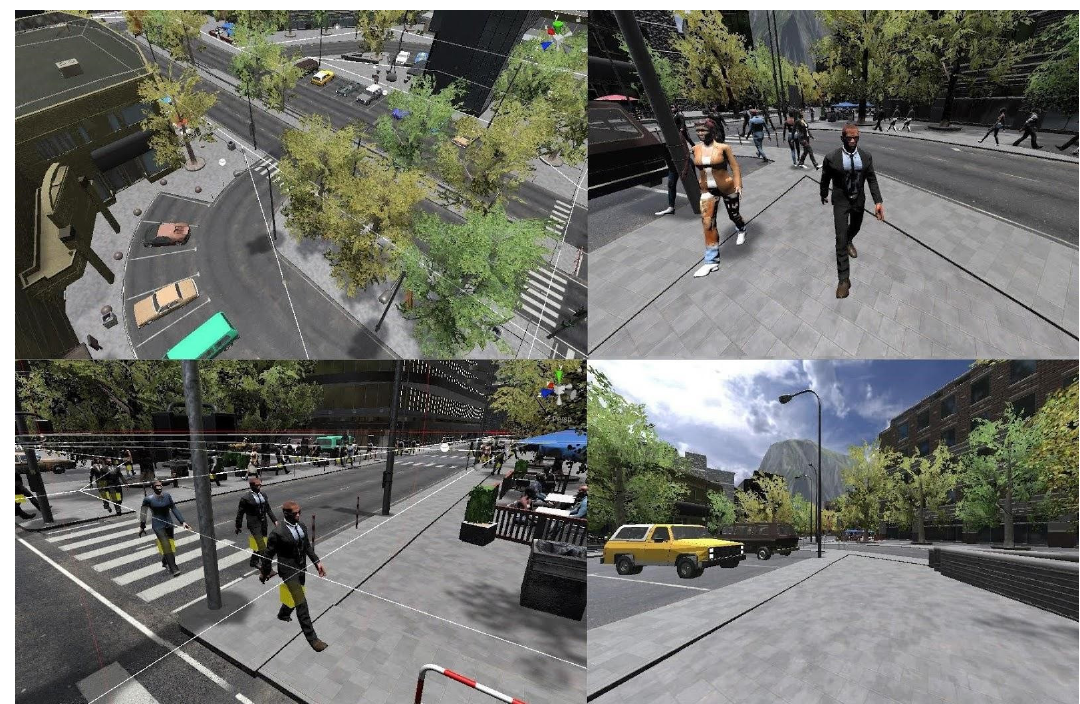
Figure 5. Virtual environment for testing .